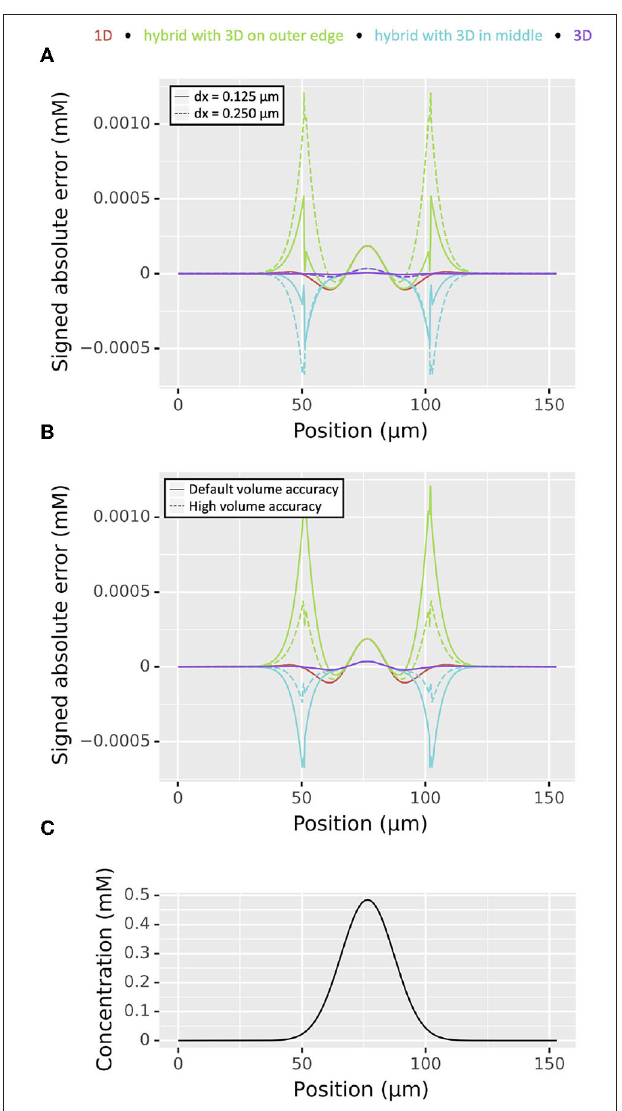
FIGURE 9 | Comparison of the magnitude of signed absolute errors as a function of position for 1D (red), 3D (green), and two hybrid cases (cyan and purple) for diffusion from an area of elevated concentration near the middle of a 153 µ m long cylindrical domain ; all plots are for t 50 ms. (A) With different = choices of dx. (B) With dx = 0.25 µ m and different levels of accuracy for estimating the partial volume of voxels that are partly inside and partly outside the cylinder; see text for details. (C) Analytically computed concentration